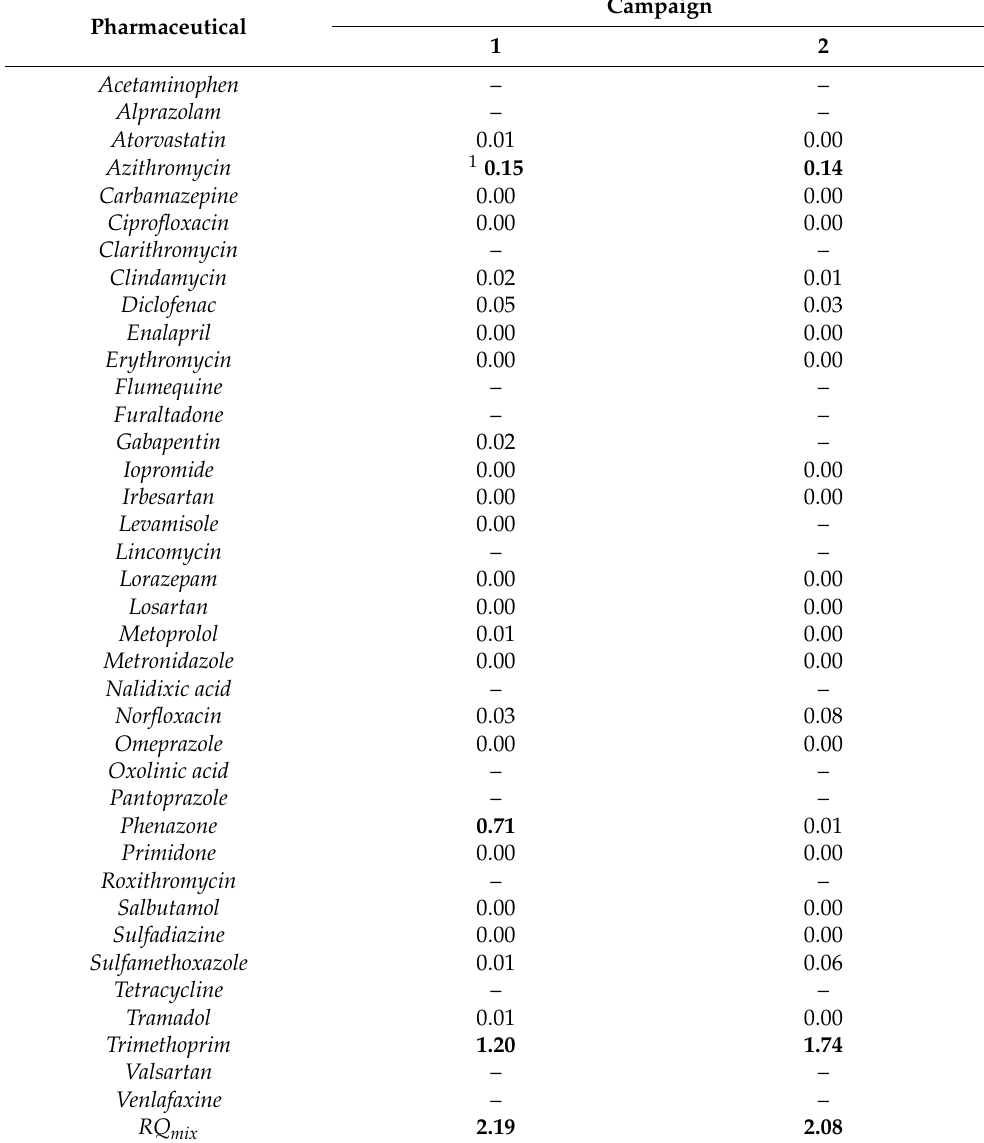
Table 6. RQ p values for the pharmaceuticals after the conventional treatment ( Scenario c ).